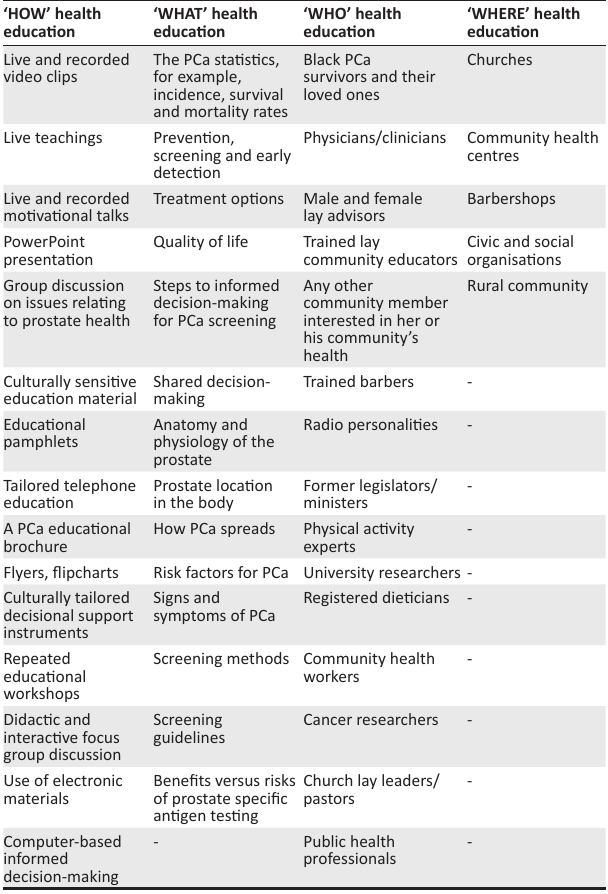
TABLE 3: Outcome of the